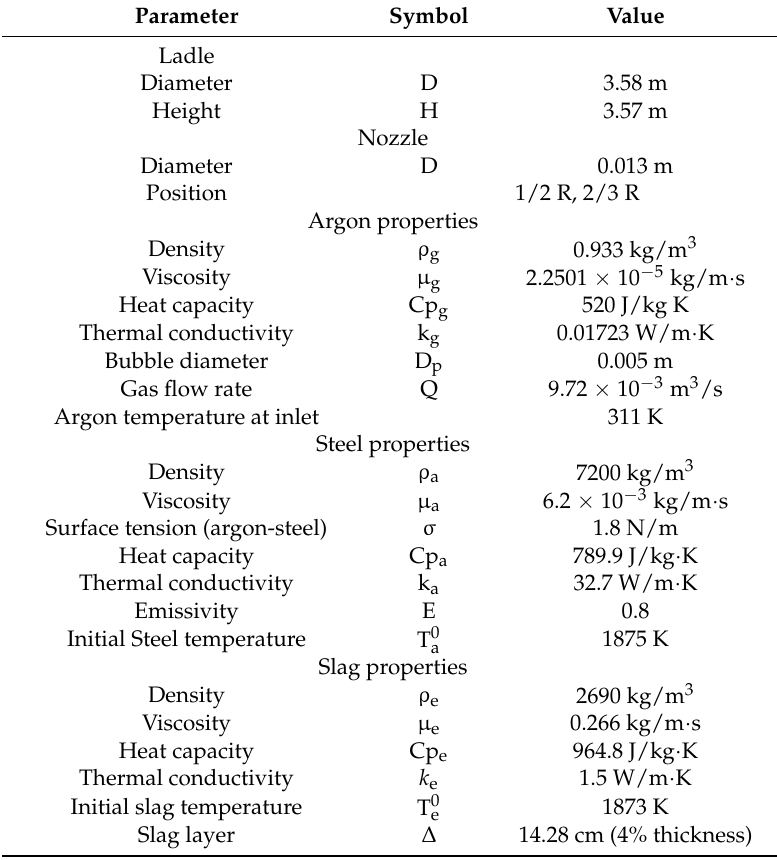
Table 3. Geometrical and physical variables needed for the